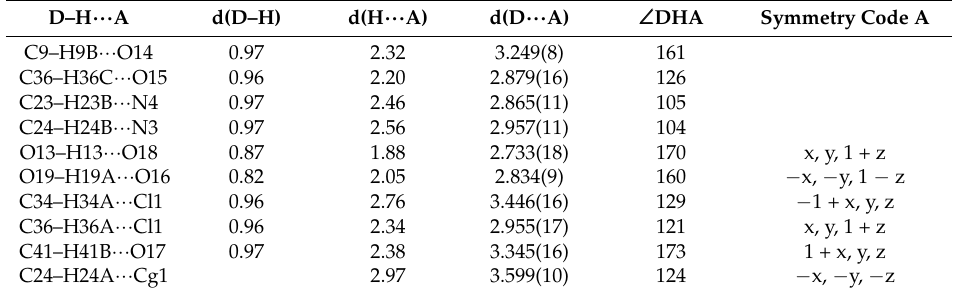
Table 4. Hydrogen bonds (Å, deg) and C–H ··· π stacking interactions for the Co(II)-Ce(III)